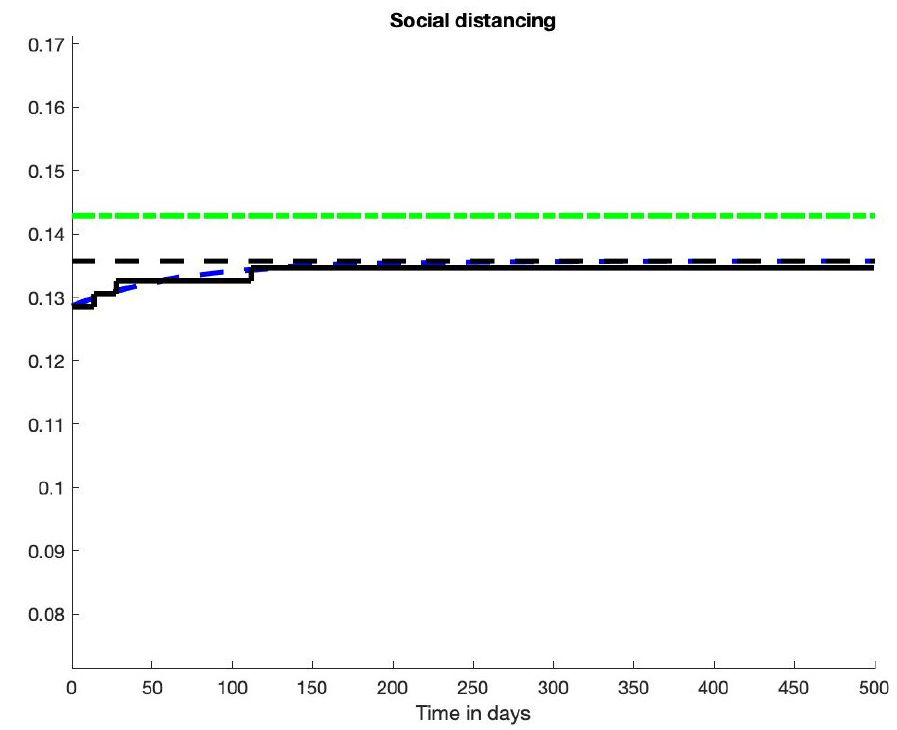
Figure 13. Scenario 6: Control. β , β ∗ (- -,blue), γ (- ., green) and β acceptable (- -,